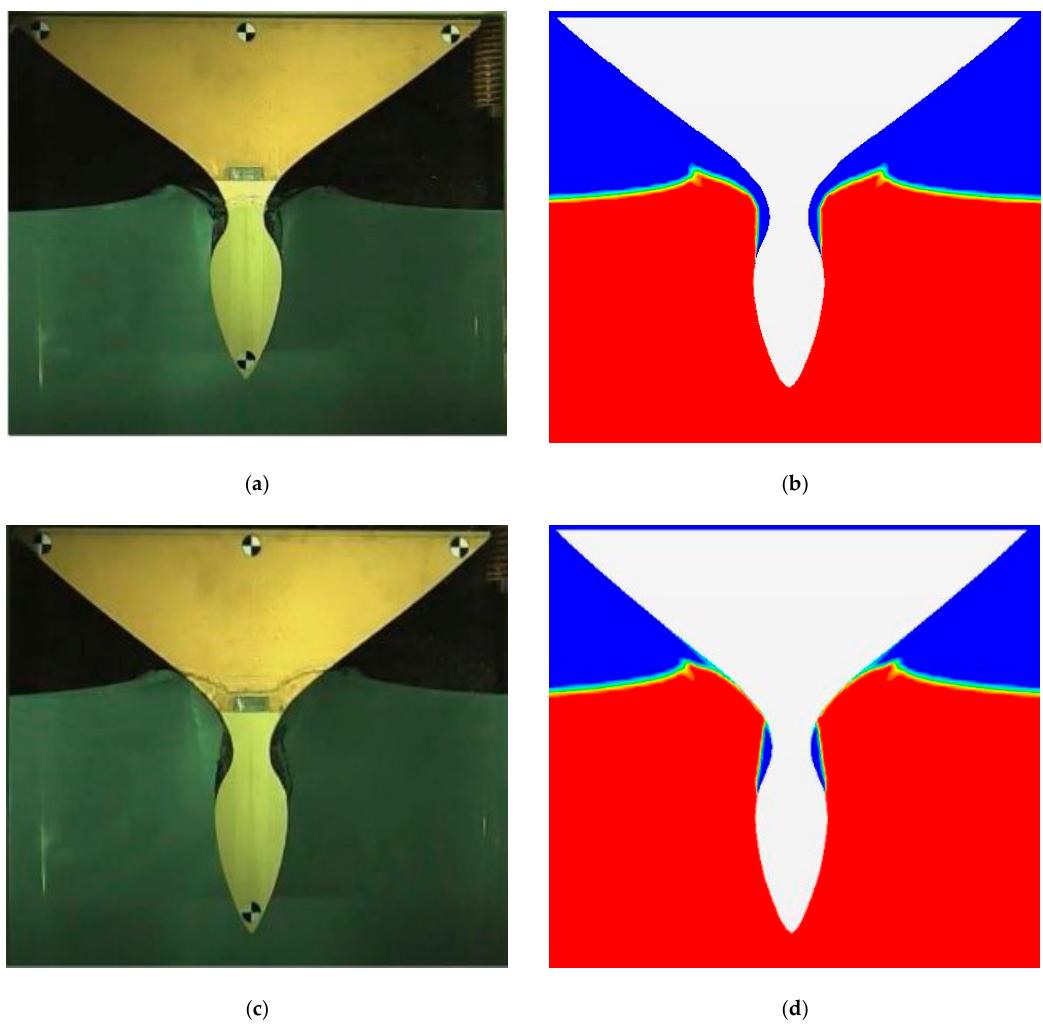
Figure 10. Free surface elevations obtained by the present numerical method and the drop test in MOERI (2013): ( a ) the drop test (0.24 s); ( b ) the present method (0.24 s); ( c ) the drop test (0.26 s); ( d ) the present method (0.26 s).